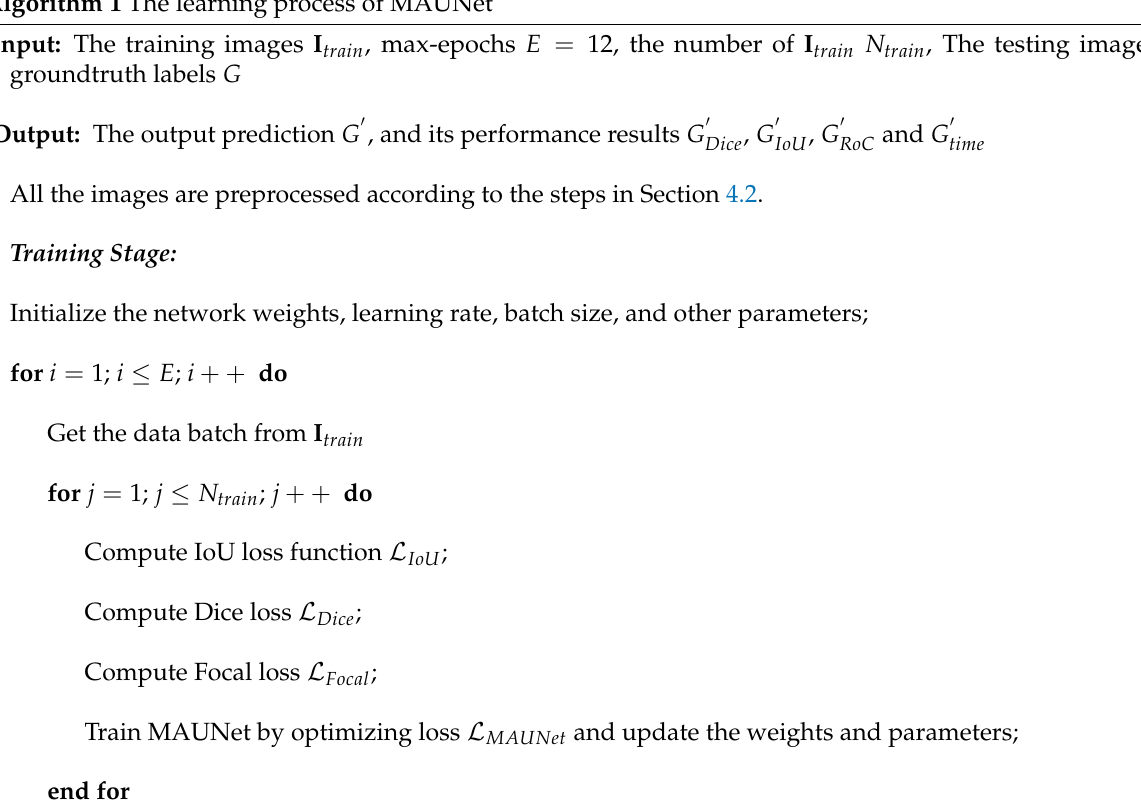
Algorithm 1 The learning process of